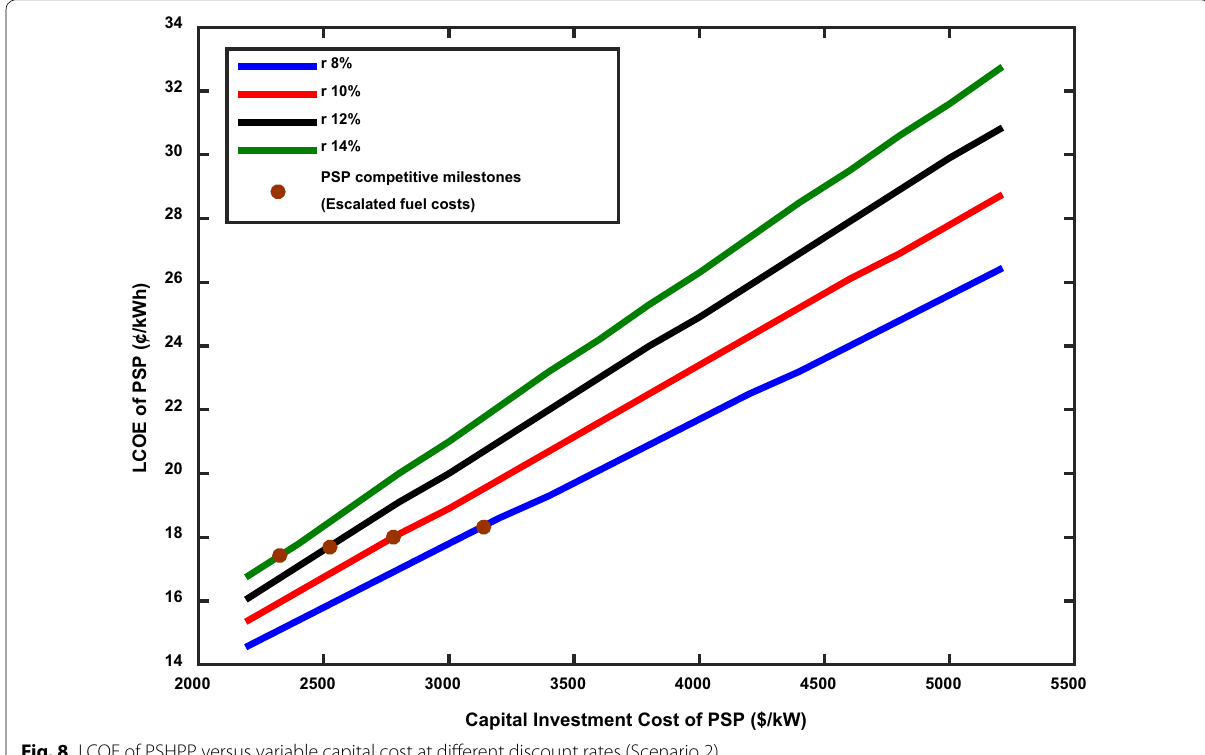
Fig. 8 LCOE of PSHPP versus variable capital cost at different discount rates (Scenario 2) Table 2 Constants derived for each pumping scenario and discount rate Pumping cost scenario Regression equation